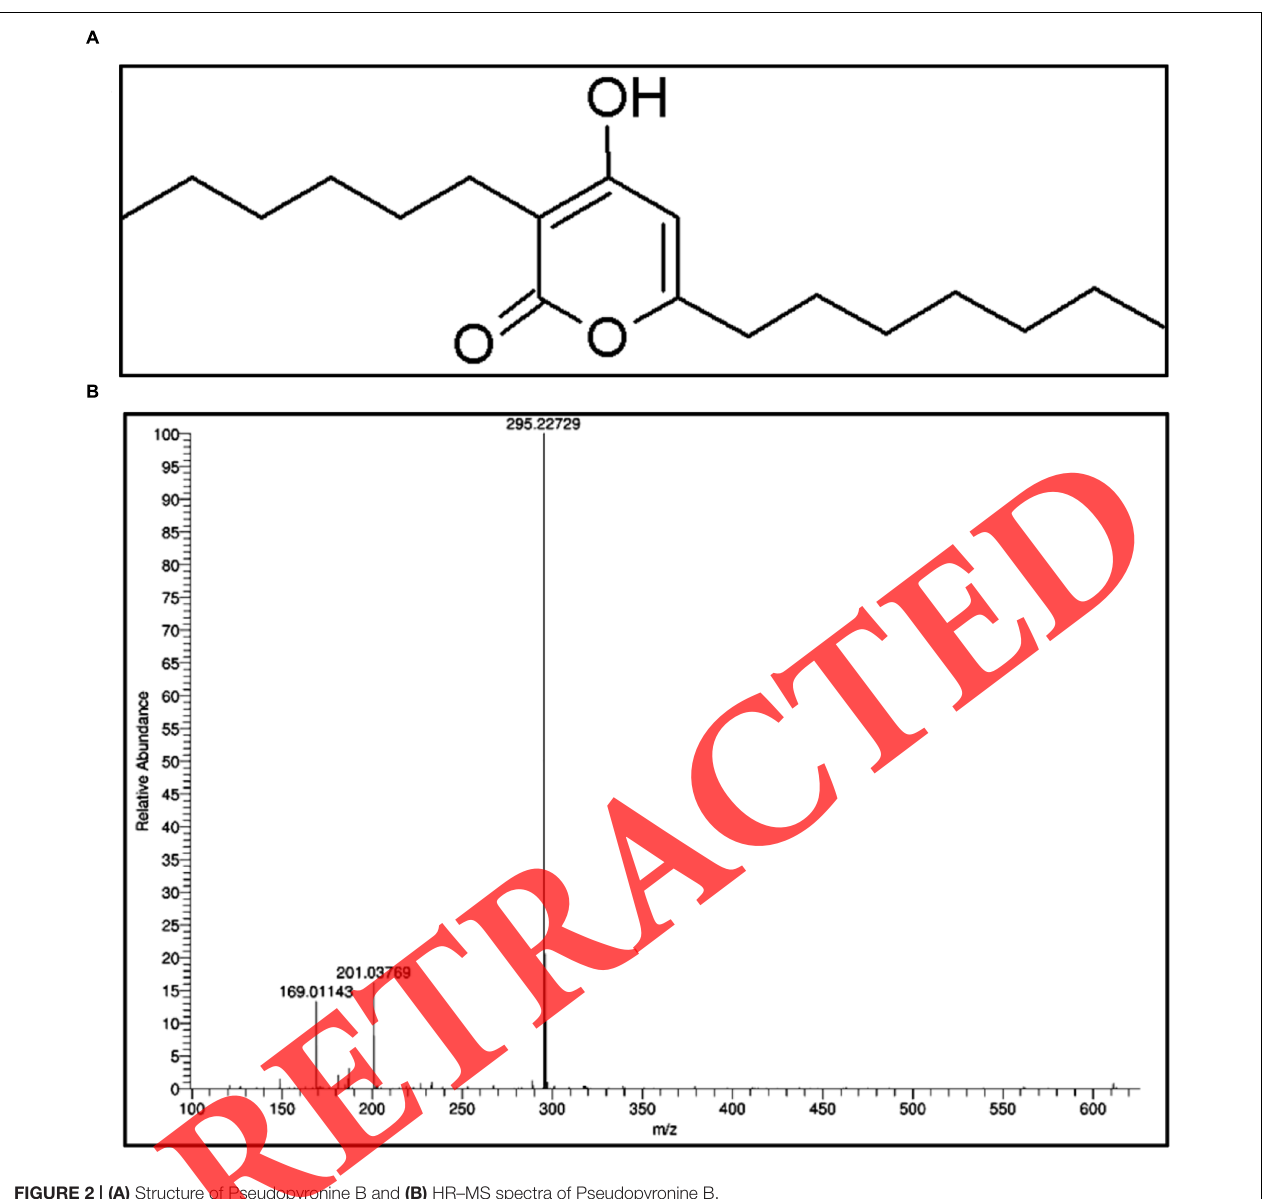
FIGURE 2 | (A) Structure of Pseudopyronine B and (B) HR–MS spectra of Pseudopyronine